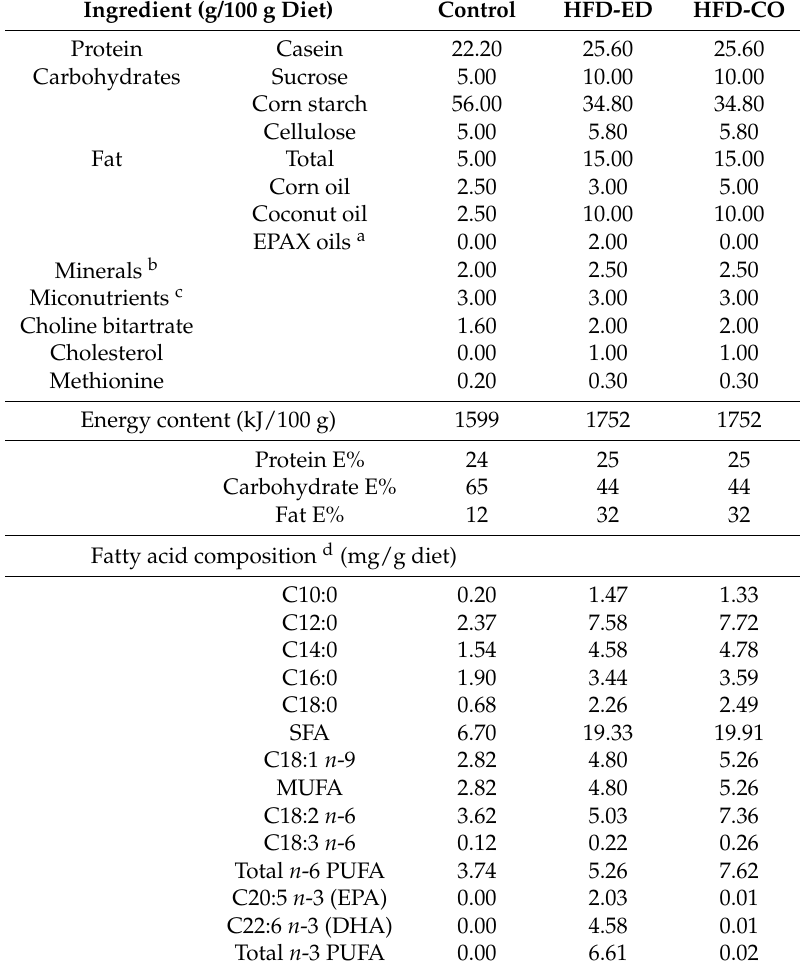
Table 1. The composition of the different diets used in this study. Data are adapted from [22]. Control = control chow; HFD-ED = high fat diet—eicosapentaenoic acid and docosahexaenoic acid; HFD-CO = high fat diet—corn